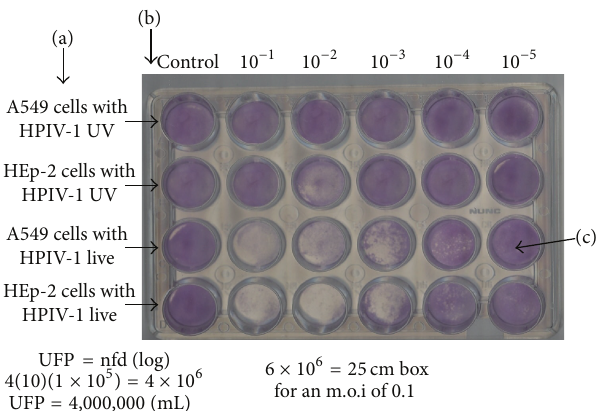
Figure 1: Lytic plaque assay. The number of viral particles was determined by dilution. In a 24-well plate with HEp-2 and A549 cell cultures, each lytic plaque that develops is initially related to a single infectious virion particle. This method was performed to determine the viability of both viruses, live and inactive. (a) refers to the cell type and the characteristic of the virus (inactive and live); (b) corresponds to dilutions ranging from 10 −1 to 10 −5 ; and (c) refers to plaque-forming units. This assay was performed in